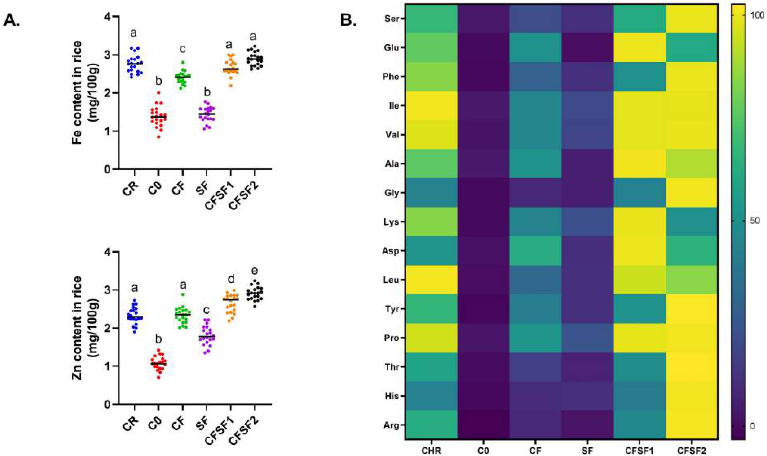
Figure 4. The effects of SF in paddy rice ( A ) micronutrients (Fe and Zn) and ( B ) amino acid composition. Different annotation letters indicate significant difference ( p < 0.01) between groups.